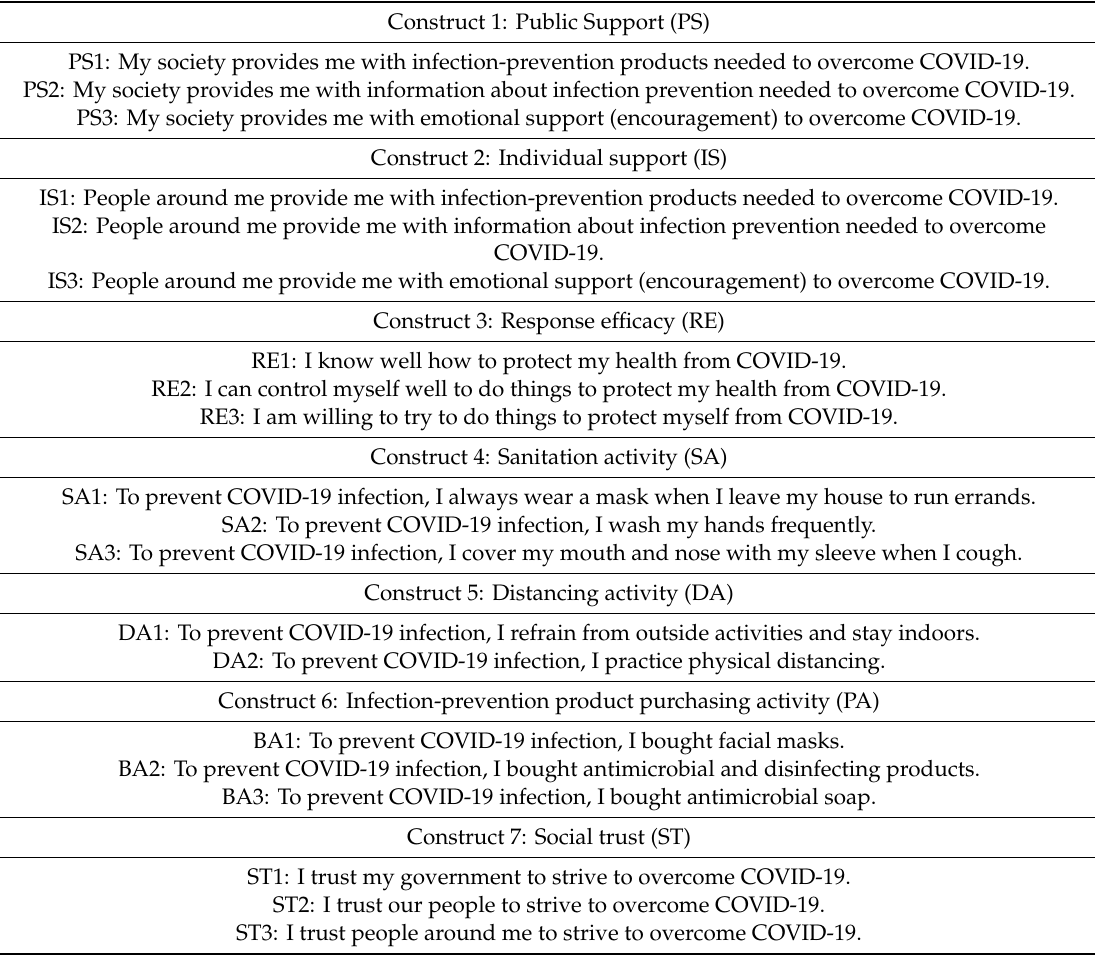
Table 2. Constructs and Survey